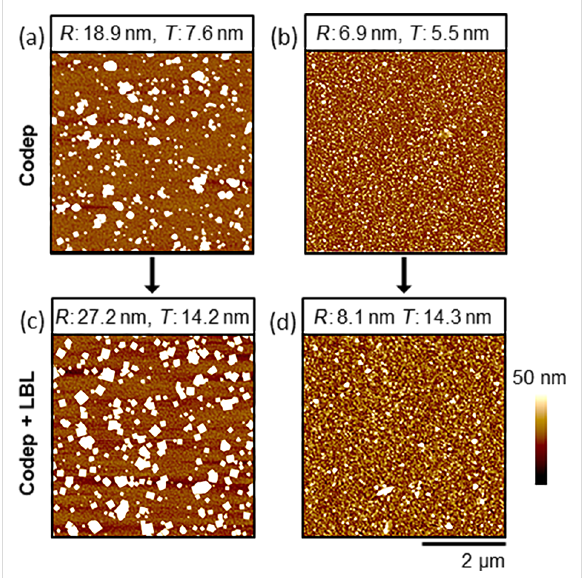
Figure 3: Representative AFM images (5 μ m × 5 μ m) of HKUST-1 surMOFs fabricated via codeposition (codep) at 25 °C for 1.5 h (a) and 50 °C for 5 h (b) on SAM-coated Au surfaces. Additional layers of HKUST-1 were added to these codeposited samples via layer-by-layer (LBL) deposition. The subsequent surface morphology was imaged (c,d) and the previous surface morphology was maintained. Data regarding the roughness ( R ) for the image shown here and average film thickness ( T ), as measured by ellipsometry, are provided above the images for comparison. All images were set to the same z -scale (50